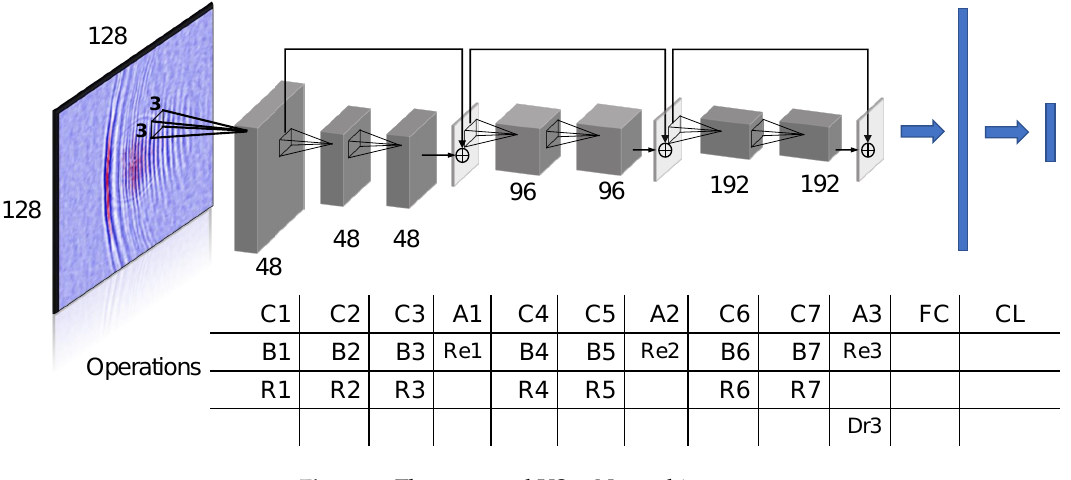
Figure 5. The proposed USresNet